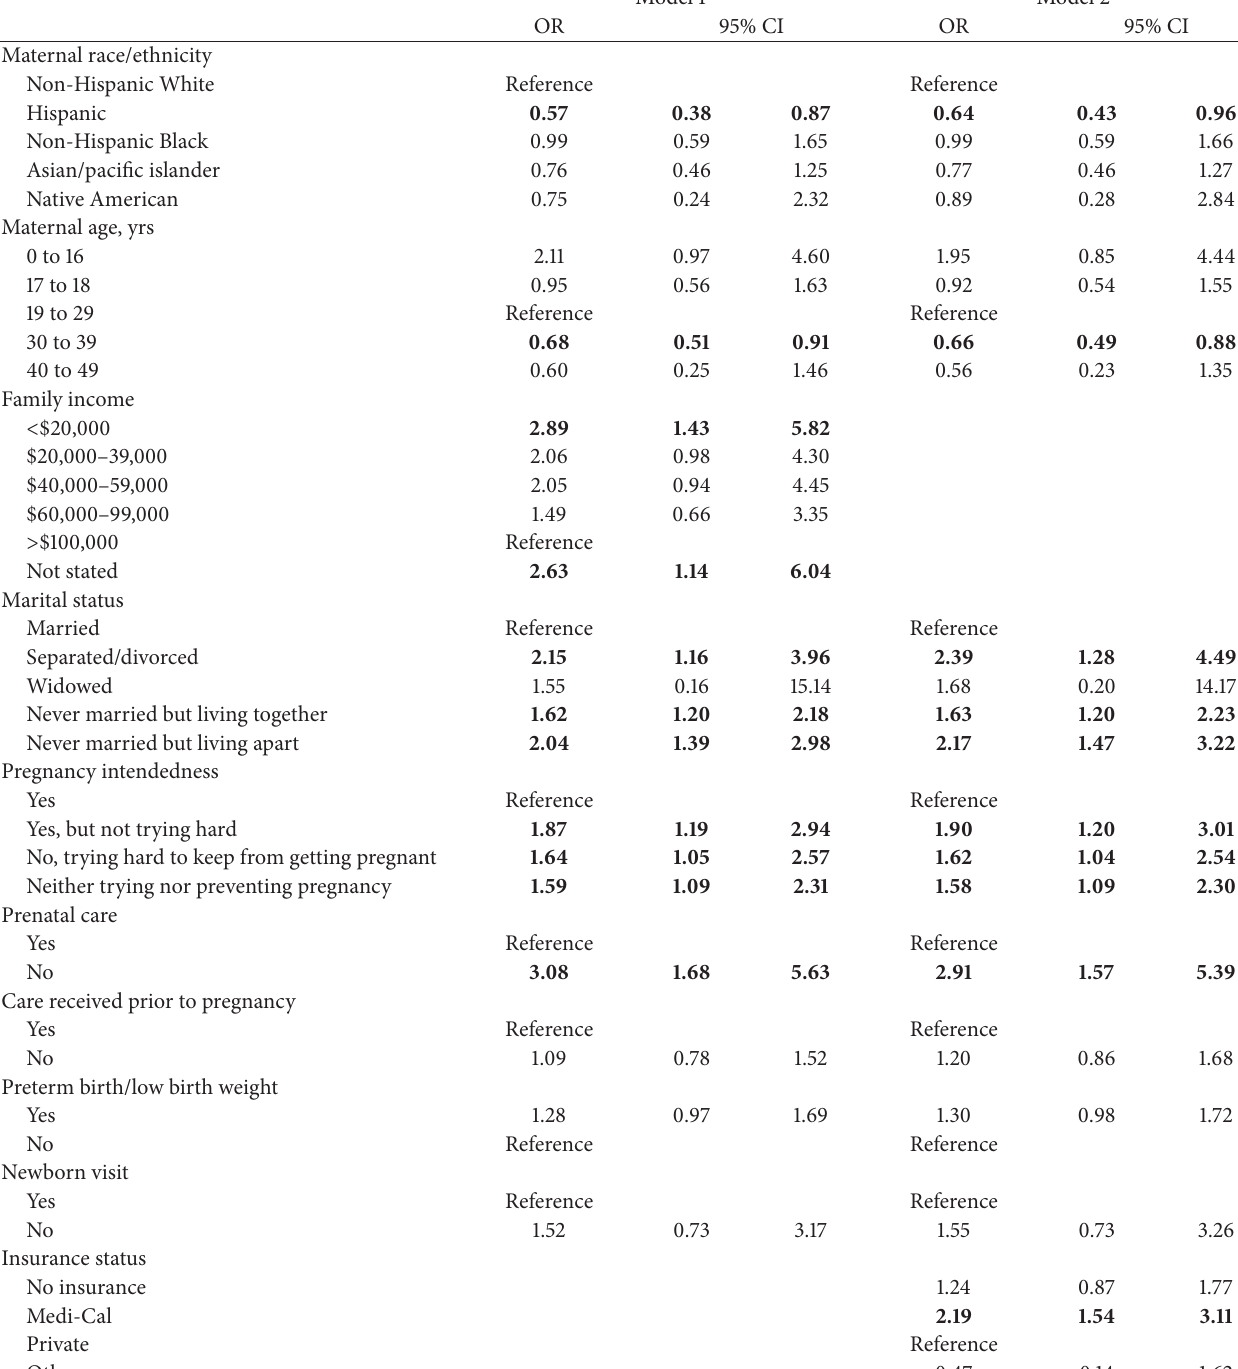
Table 3: Adjusted odds of lacking a postpartum visit among women who gave birth in Los Angeles County. 2007